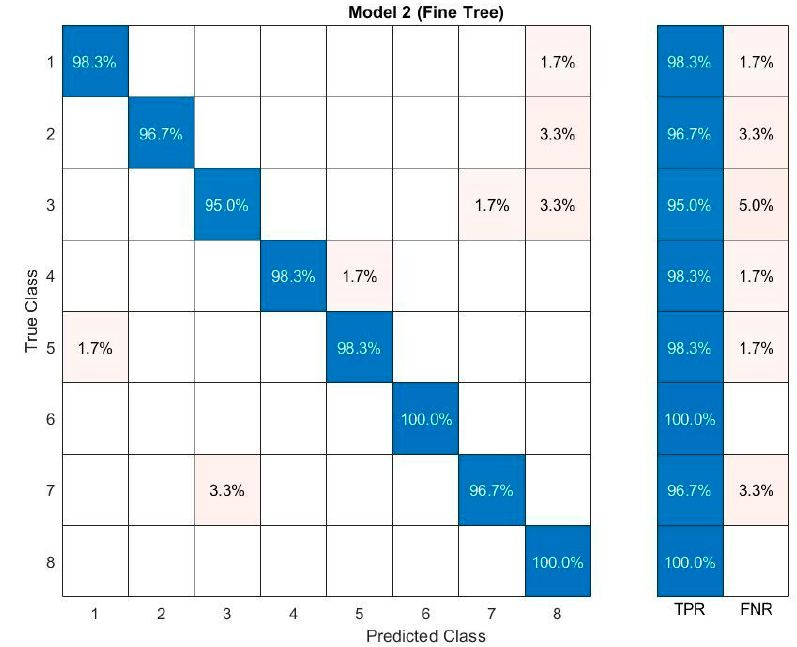
Figure 6. Demonstration of response of the prediction.